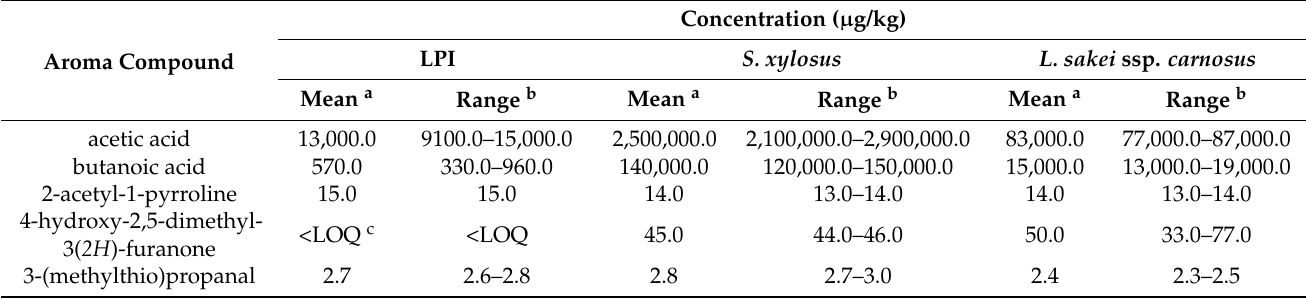
Table 3. Concentration of five selected aroma-active compounds in non-fermented LPI and with S. xylosus (DSM 20266) and